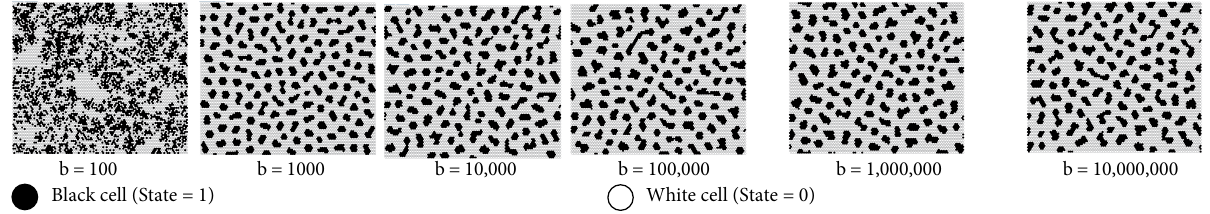
Figure 10 : Simulation results for 𝑏 ( w = 0.6 , 푟 = 0.05 , 푑 = 0.008 ) . The number b of tokens in each black cell does not affect the simulation results for 1000. This is because the transition function depends only on the ratio of tokens. For example, if is increased 10 times, the values on both sides of the function (3) also increase 10 푏 ≳